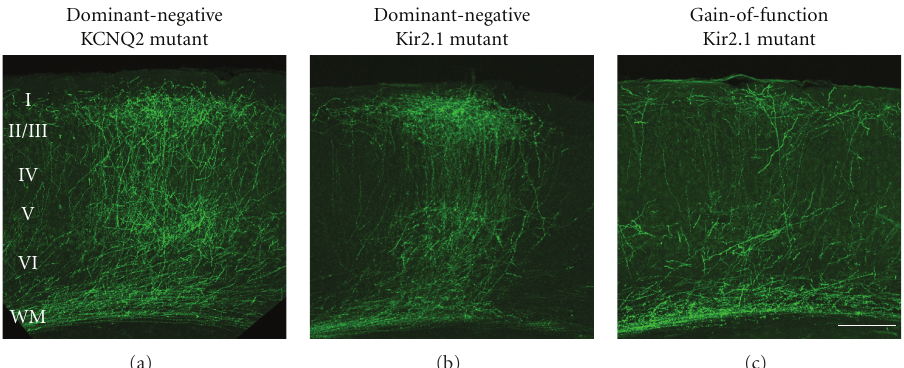
Figure 3: E ff ects of expression of several ion channels on callosal axon projections. (a) Expression of a dominant-negative KCNQ2 K + channel [94] does not influence callosal axon development. (b) A disease-causing, dominant-negative Kir2.1 mutant does not impair callosal axon projections. (c) Expression of a gain-of-function Kir2.1 mutant in callosal projection neurons impedes their axonal projections. Scale bar, 200 μ m. Adapted from